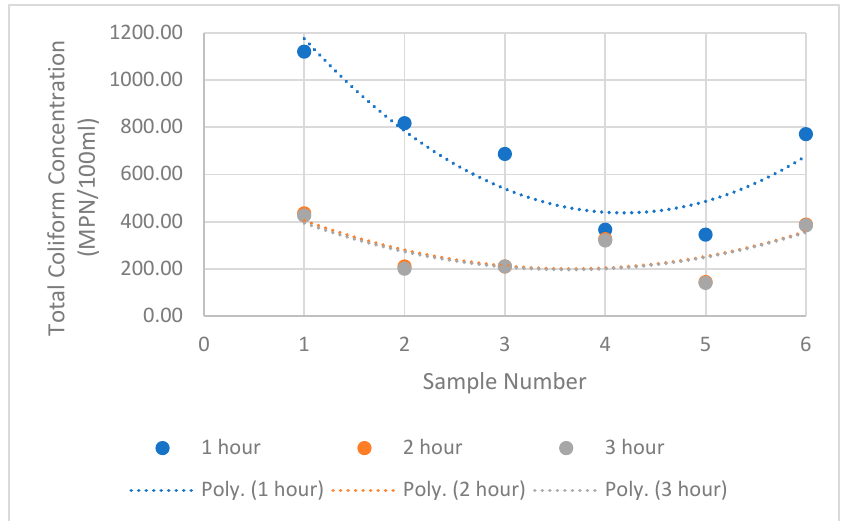
Figure 3. Variation of total Coliform count with time with different hybrid mixtures.